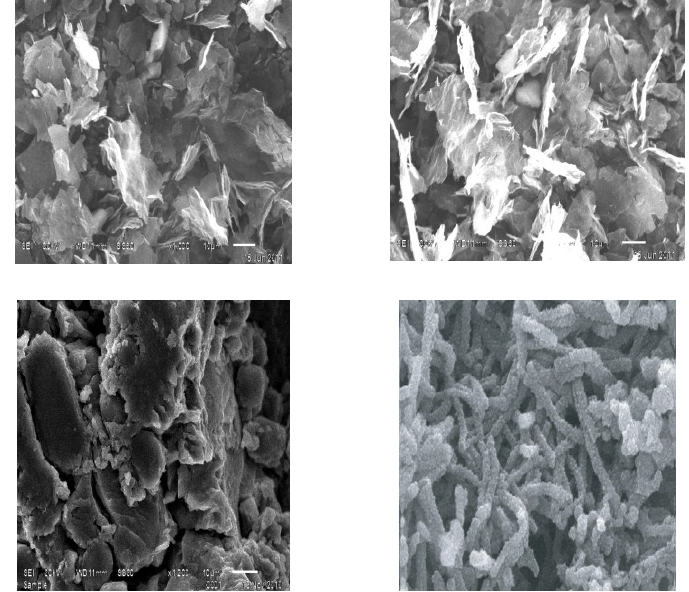
Figure 1. SEM image of DSBA doped tetraaniline prepared at different molar ratios of N- phenyl-1, 4-phenylenediamine to DBSA (a) 1:2, (b) 1:3, (c) 1:4, and (d)